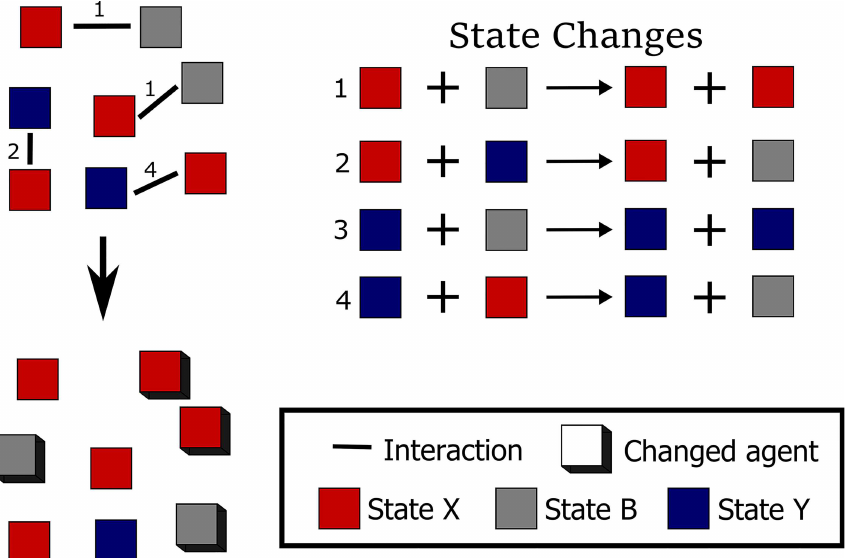
Fig 1. Population protocols. A communication protocol is, in general,a set of rules about how a set of agents can interact. In populationprotocols, in particular, these rules very closely mirror assumptionsabout chemical solutions.Namely, agents interact only in pairs (like in a molecularcollision), the next pair to interact is chosen randomly (like in a well-mixedsolution), each agent can have only a finite number of states (like phosphorylation states), and each interactioncan result in a changeof state in either or both agents. It is therefore easy to draw a parallelbetweenagent states and chemicalspecies (interacting molecules)and betweenbinary interactions and bimolecular reactions(unimolecular reactions can be handledas a special case). In that way, populationalgorithmscan be translated into chemicalreaction networks and vice versa [23]. Populationprotocolsare also used at a different abstractionlevel, modelling interactionsbetween species of a biologicalpopulation[24]. The set of four state changesin this figure implementsthe Approximate Majority populationprotocol. Each square is an agent in one of its three possiblestates (colours). Pairs of agents have the potentialto interact accordingto the left-hand-side patterns of the state changesand produce new states accordingto the corresponding right-hand-side patterns. The interactionsthat actually happenare determined randomly, but starting from the configuration on the top left they may result in four steps in the new configuration on the bottom left, where further interactionsbecome